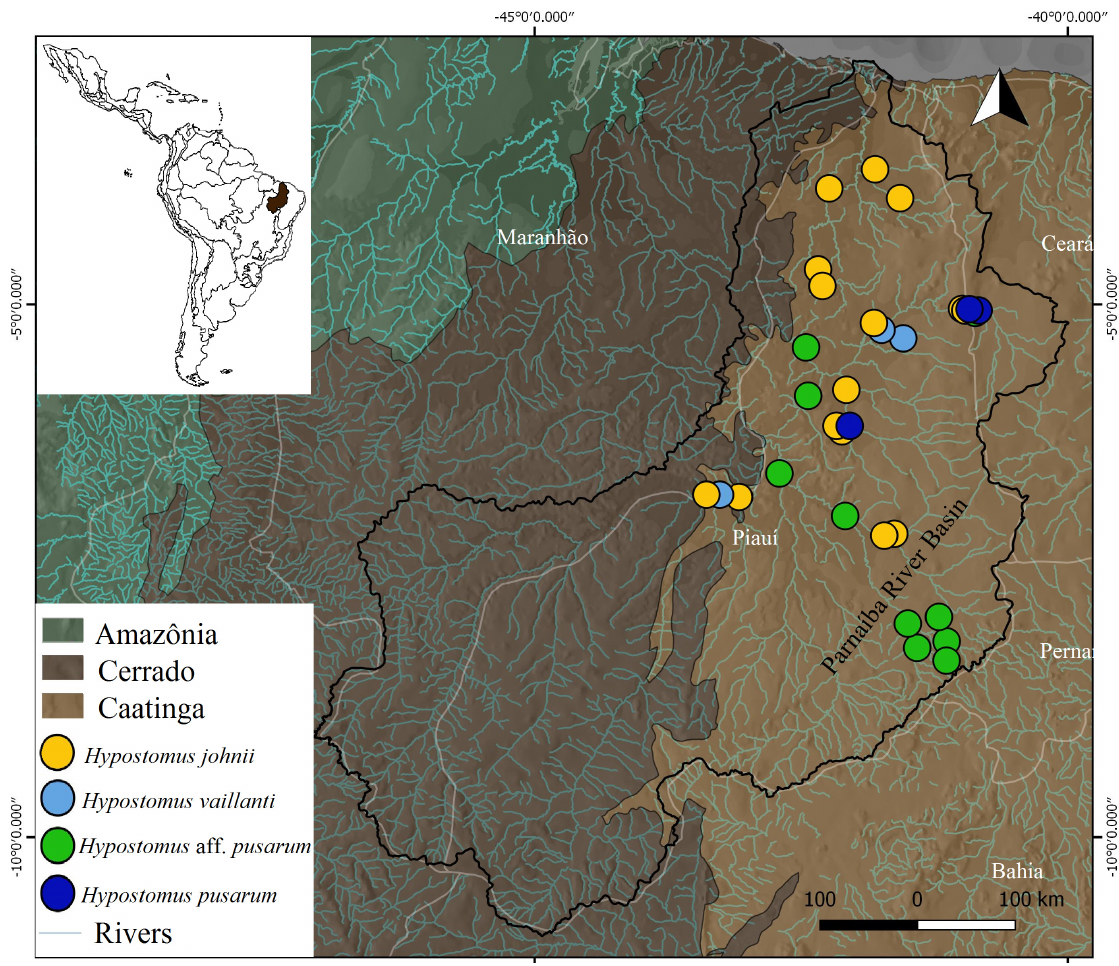
FIGURE 11 | Hypostomus species distribution map from the Parnaíba River basin, Northeast Brazil (except H. velhomonge , depicted in Fig.6), with biome